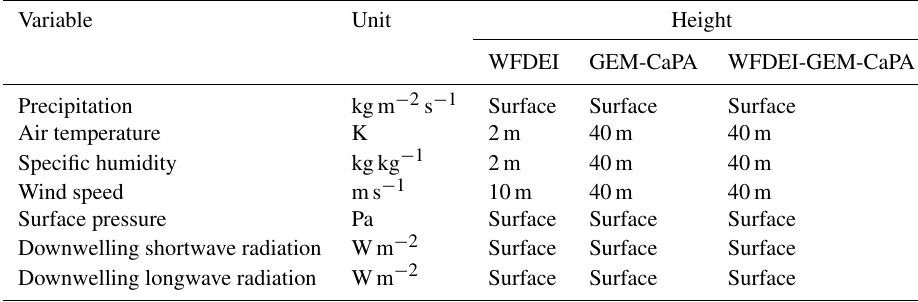
Table 2. List of variables processed in this study with heights and units in each